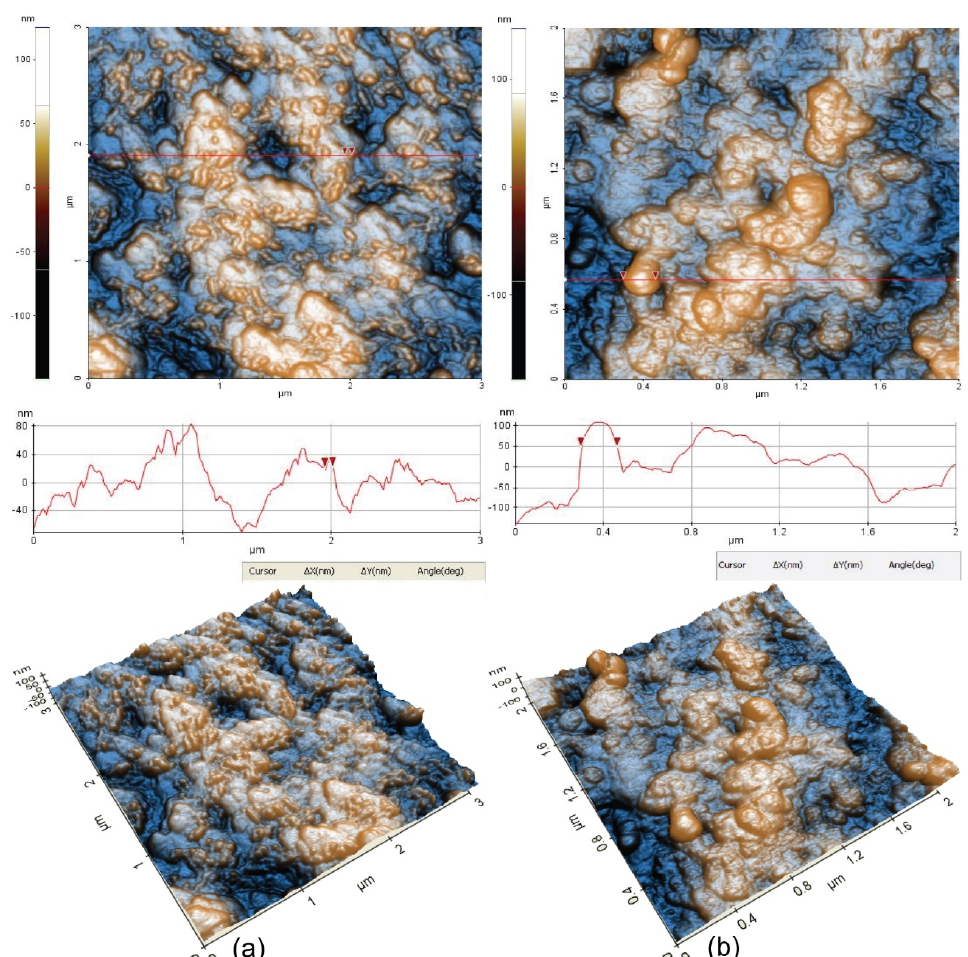
Figure 10. The 2D and 3D AFM topographic images of Sample 1(initial) ( a ) and Sample 2 (corroded) ( b ) at the scale of (3 μm × 3 μm); representative line scans are shown, collected at the position indicated by a horizontal red-line in the 2D AFM images. Coatings 2021 , 11 , x FOR PEER REVIEW